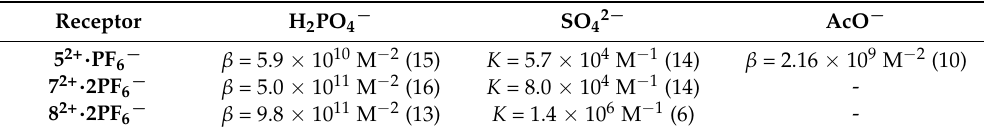
Table 1. Association constants for receptor 5 2+ · PF 6 − , 7 2+ · 2PF 6 − and 8 2+ · 2PF 6 − with H 2 PO 4 − , SO 42 − and